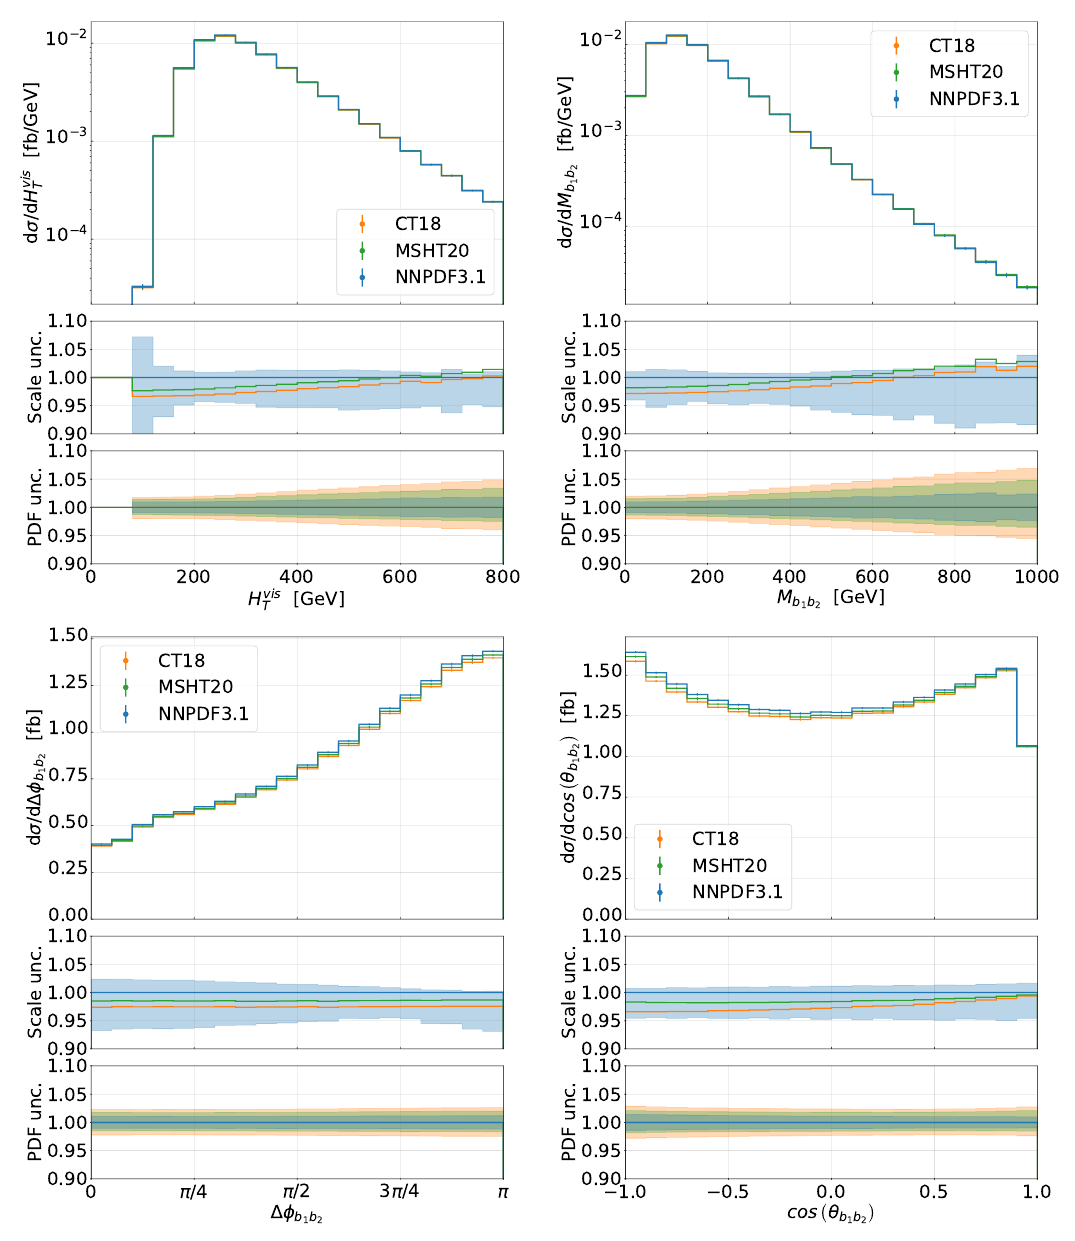
Figure 11 . Differential distributions at NLO QCD for the observables H vis cos ( θ b ) for the pp → e + ν e µ − ¯ ν µ b ¯ b H process at the LHC with 1 b 2 show the NLO prediction for three different PDF sets, NNPDF31, MSHT20 and CT18 and with µ 0 = H T / 2 . Also given are Monte Carlo integration errors. The middle panels display the ratio to the NNPDF3.1 set and its scale dependence. The lower panels give the PDF uncertainties obtained for each PDF set